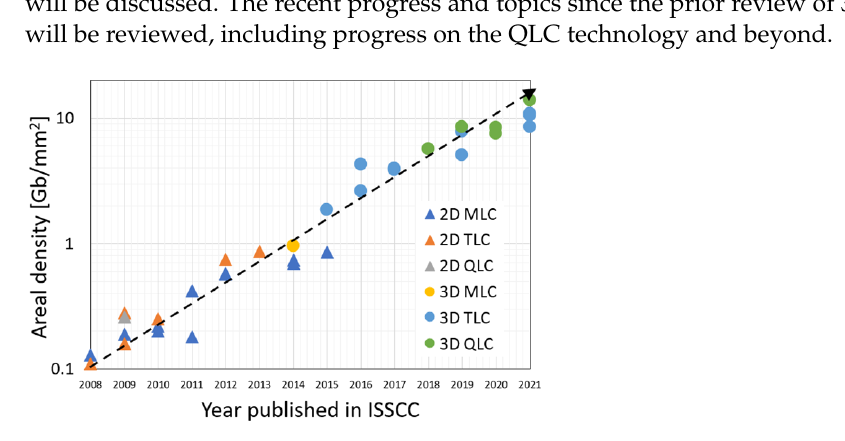
( a ) ( b ) Figure 2. 3D NAND array architecture. ( a ) Schematics of 3 × 3 NAND strings and ( b ) bird’s eye view of 3 × 5 NAND strings. Only 4 word lines (WLs) in a string are shown for visibility. The actual 3D NAND has more than 128 WLs in a string. A block is a unit of the erase operation. As shown in Figure 3, there are two types of erase methods in 3D NAND — the body erase (Figure 3a) and the GIDL erase (Figure 3b) [1,35]. In the body erase, NAND strings are connected to the Si-substrate, and holes are supplied to the NAND string from the Si-substrate, enabling the positive body potential required for erase. In the GIDL erase, the NAND strings are de-decoupled from the Si- substrate and formed on the N+ source layer instead. During erase, the electron-hole pairs are generated at source and drain N+ junctions by GIDL mechanism to supply holes to